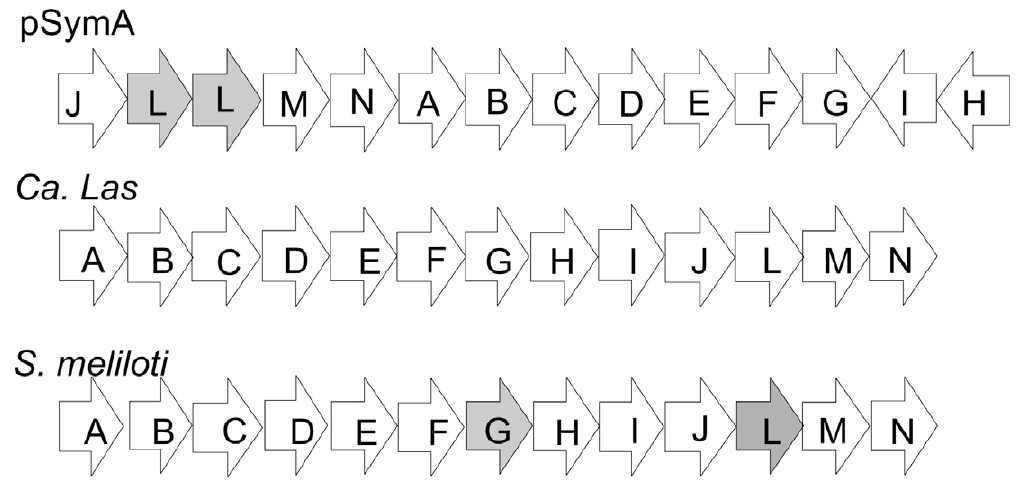
Figure 2. Diagram showing the organization of the genes encoding the components of the NADH dehydrogenase complex on pSymA, ‘ Ca . Liberibacter asiaticus’ and S.meliloti . doi:10.1371/journal.pone.0038725.g002 PLoS ONE |